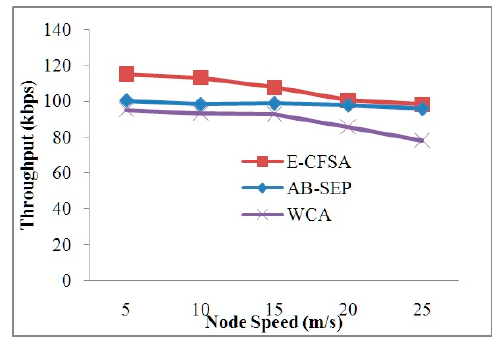
Figure 13. Graph throughput Vs. Node speed.